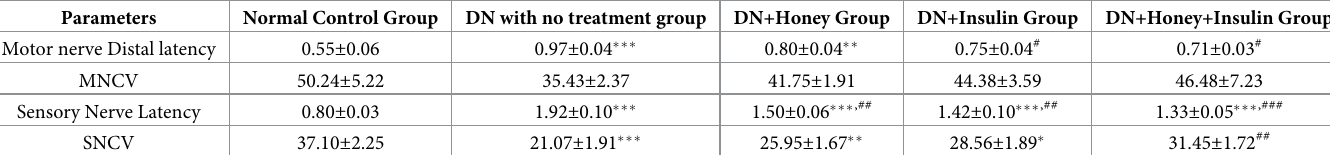
Table 4. Comparison of nerve conduction study parameters in all the groups after six weeks of intervention. Parameters Normal Control